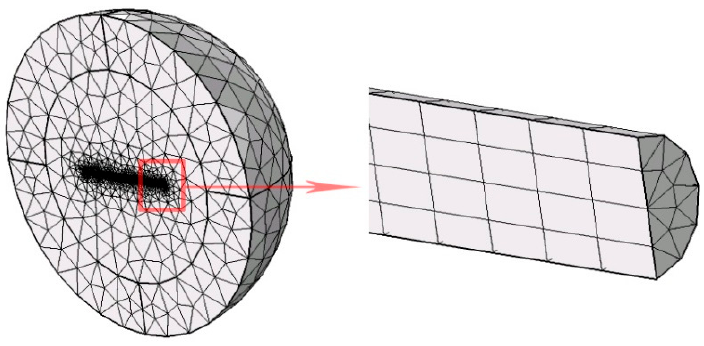
Figure 3. Thermoacoustic model of nanoresonators. Triangular prism element for the resonator and tetrahedron for surrounding medium.